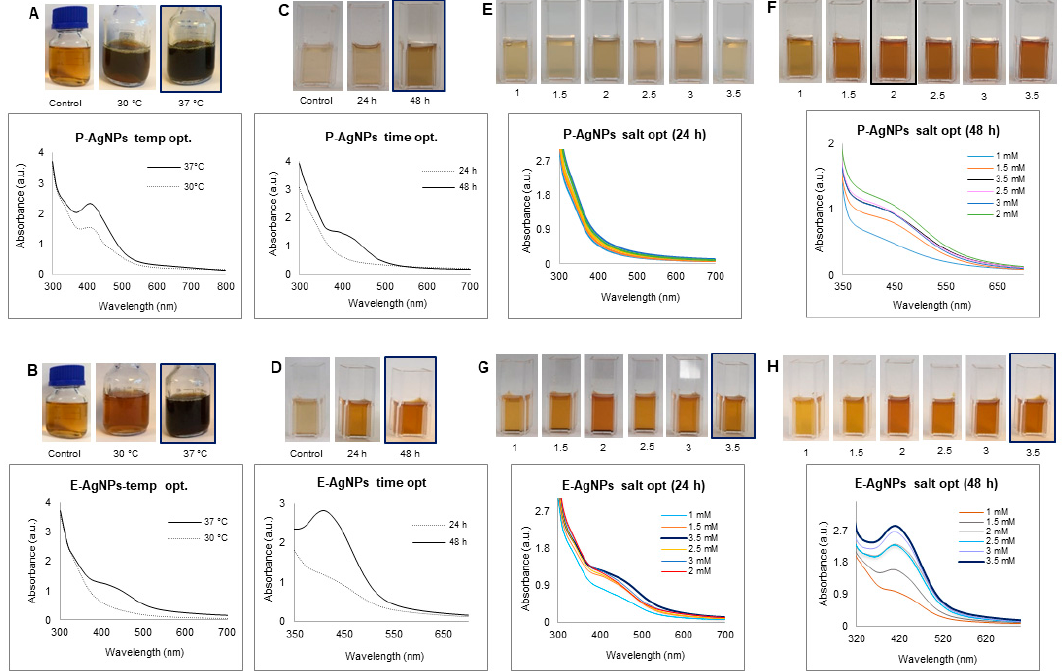
Figure 3. Optimization studies for P-AgNPs and E-AgNPs production. For P-AgNPs, visible picture and UV-Vis spectrum ( A ) temperature optimization, ( C ) time optimization, and ( E , F ) silver salt optimization at 24 h and 48 h. For E-AgNPs, visible picture and UV-Vis spectrum ( B ) temperature optimization, ( D ) time optimization, and ( G , H ) silver salt optimization at 24 h and 48 h.